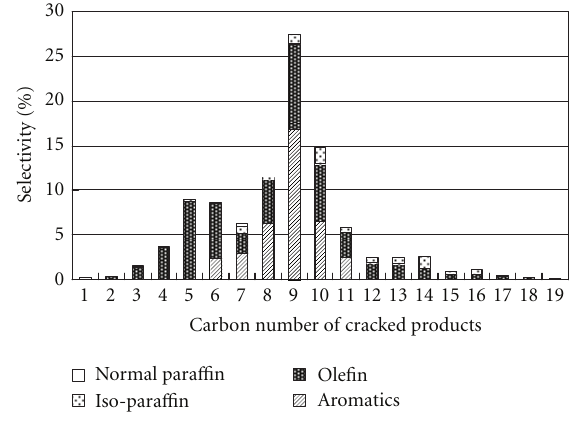
Figure 2: Product distribution over ns Al 2 O 3 /USY zeolite catalyst at 500 ◦ C. Table 1: Basic physical properties of ns Al 2 O 3 /USY zeolite